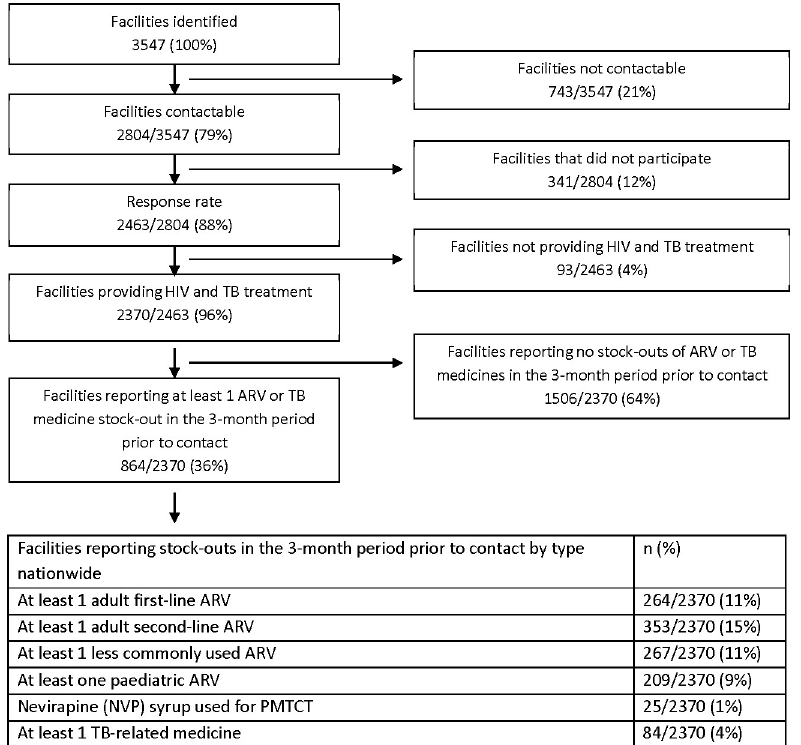
Fig 1. Study overview: Flow diagram of study population and responses.